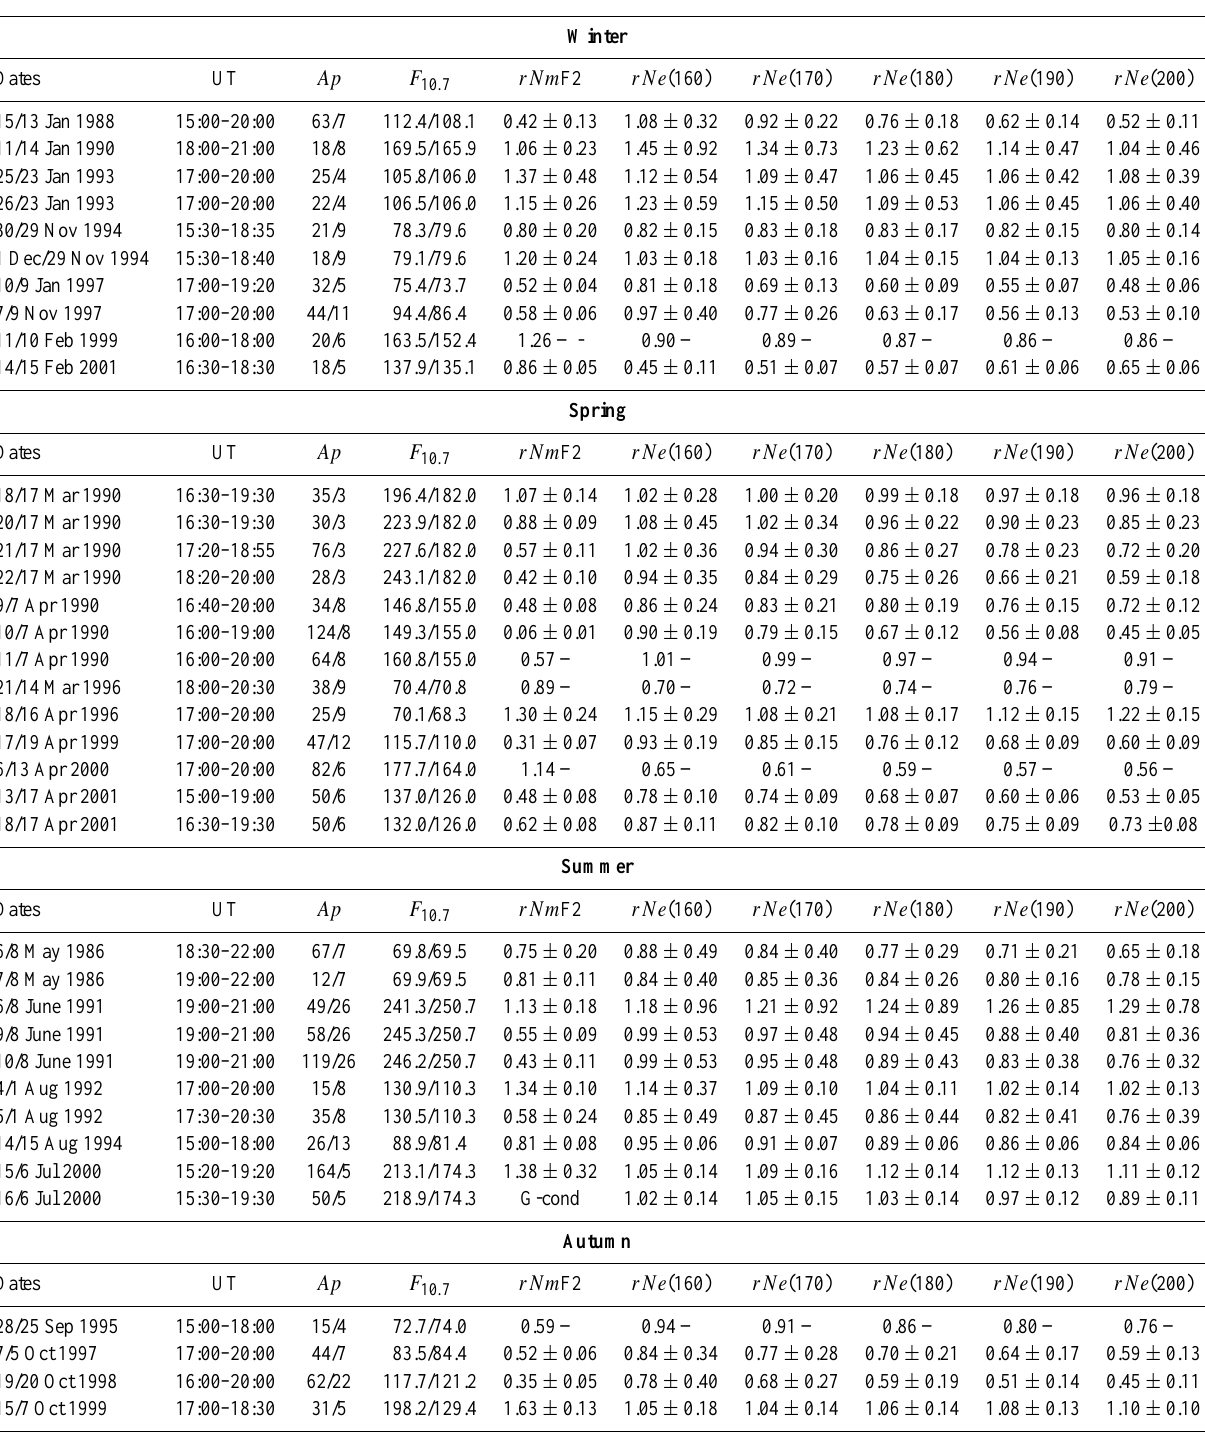
Table 1. List of Millstone Hill observations (disturbed/reference days), together with daily A p and F 10 . 7 indices. Observed rNm F2 and rNe at 160–200km heights are given, together with absolute deviations (dashes correspond to large scatter in data when calculated standard deviations are unreliable). G-conditions means the absence of the F2-layer peak,